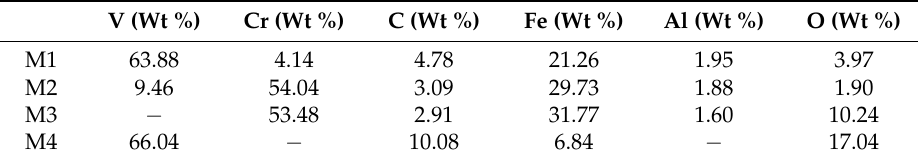
Table 2. Chemical composition of the carbides grown on D2 steel evaluated via EDS.